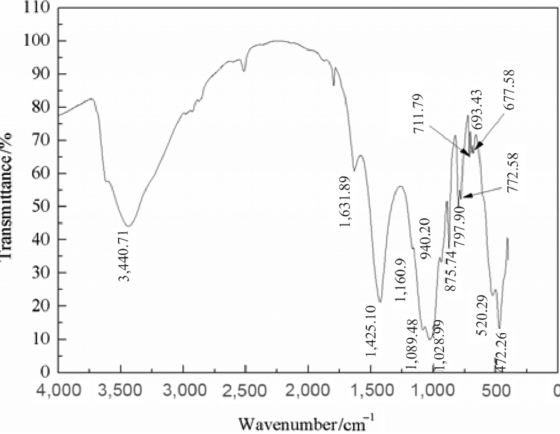
Figure 3: FT-IR spectrum of low-grade oxide zinc ore.